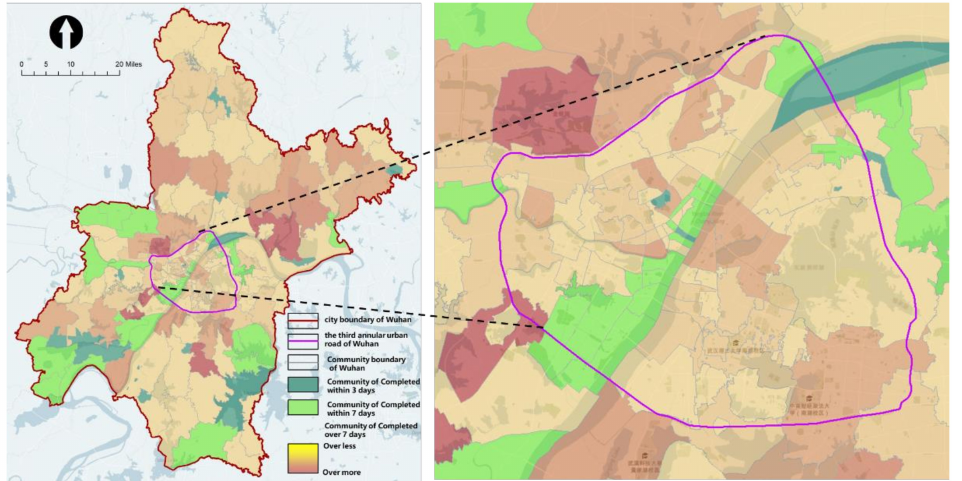
Figure 11. Time taken to complete community virus testing in Wuhan (in the late COVID-19 pandemic period).